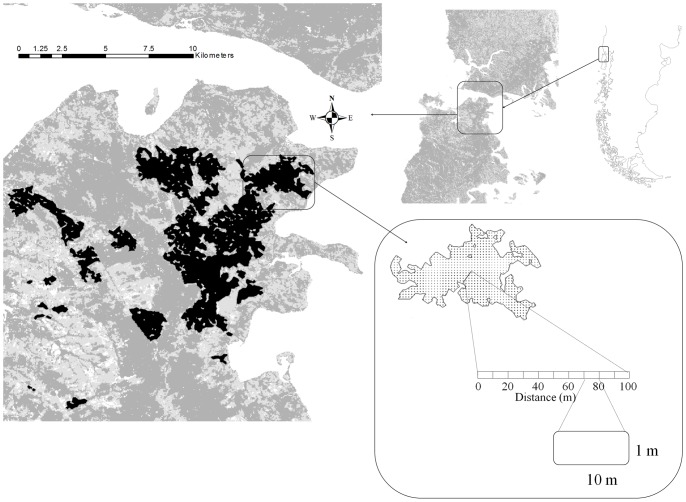
Study area and sampling design.Shaded areas indicate forest fragments, black areas indicate the 18 fragments included in the survey. Inset (lower-right corner) shows one of these fragments with a schematic representation of transects and segments used for the survey.